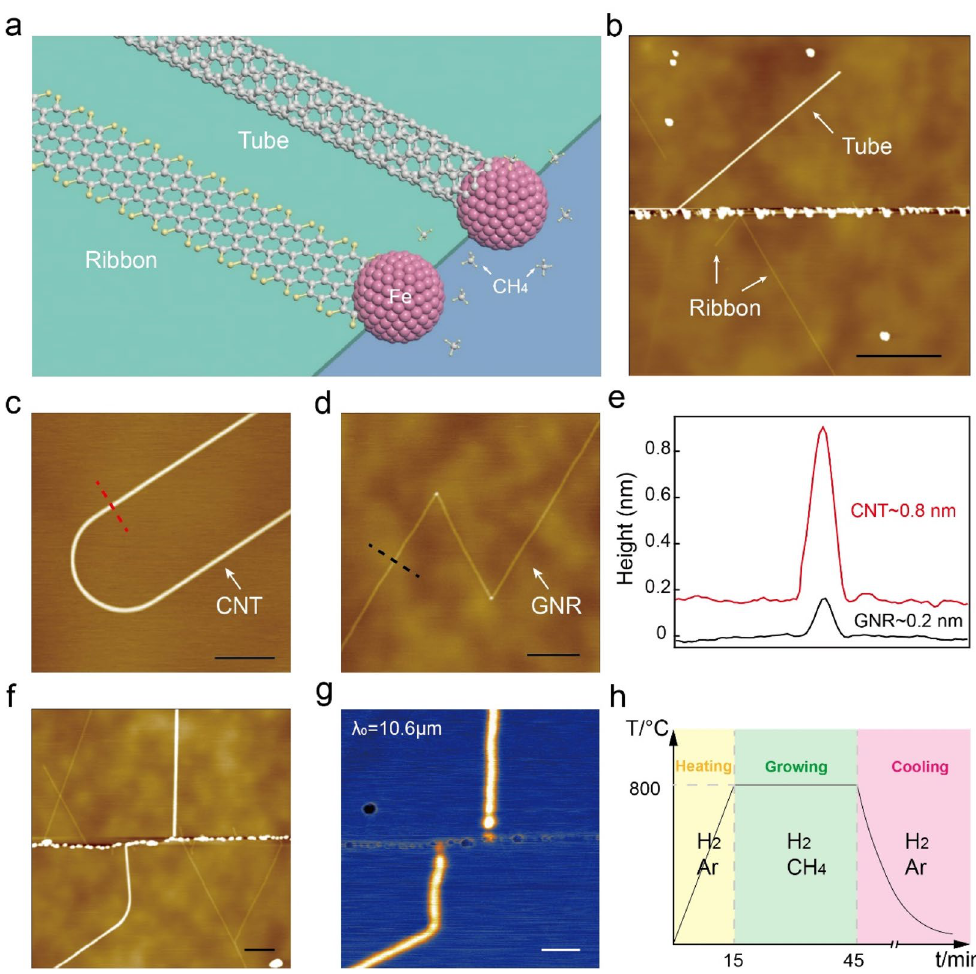
Figure 1. Growth and characterizations of GNRs and CNTs. ( a ) Schematic of GNR and CNT growth on h-BN substrate. The growth starts at Fe-nanoparticles, where methane molecules can decompose into atomic carbon, serving as source for the GNRs and CNTs growth. ( b ) AFM topography image of an as-grown sample with both GNRs and CNTs on h-BN. The higher (brighter) line corresponds to CNTs, and the lower (blurred) ones correspond to GNRs. Bright dots are Fe-nanoparticles. ( c , d ) AFM topography images of turns in CNTs and GNRs. A CNT tends to produce gentle-curved bends ( c ), while a GNR tends to produce sharp corners ( d ). This is due to the difference in their stiffness. ( e ) Height profiles of a CNT (red) and a GNR (black), taken along the dash lines in panel ( c ) and ( d ). The diameter of a nanotube is apparently larger than the thickness of a nanoribbon. ( f , g ) AFM topography image of CNTs and GNRs and the corresponding near-field infrared image of the same area. CNTs exhibit stronger response (brighter) than GNRs in the near-field optical image due to CNTs’ stronger optical conductivity. ( h ) Illustration of a typical growth process. Scale bars: 500 nm in ( b ); 100 nm in ( c , d , f , g